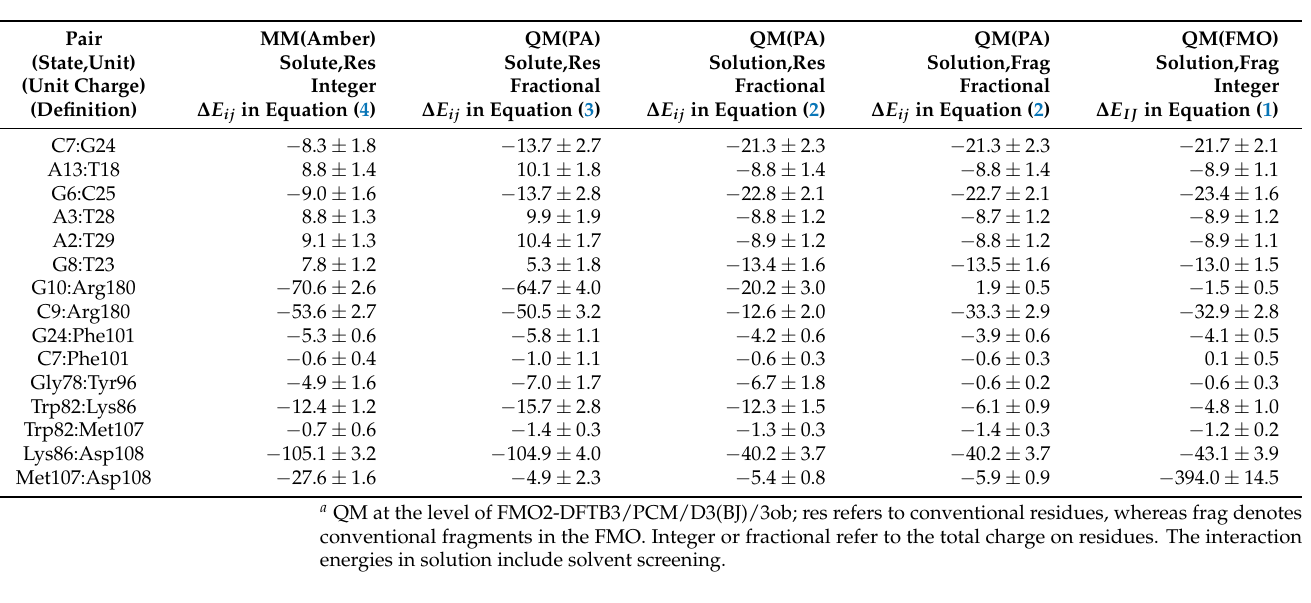
Table 1. Selected pair interaction energies (kcal mol − 1 ) in the protein–DNA complex (PDB: 2o8b), averaged over 100 snapshots of the MD trajectory a .